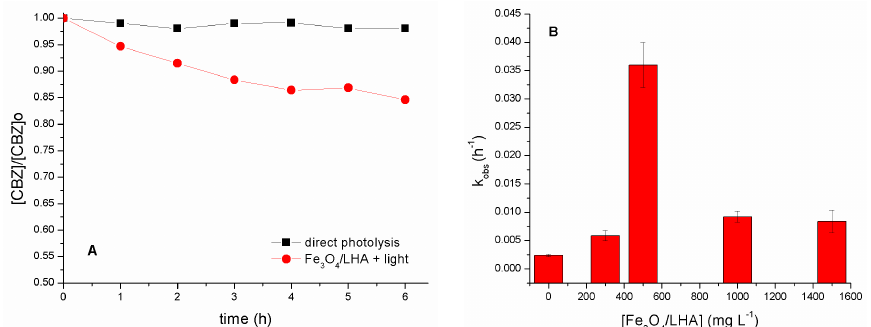
Figure 1. ( A ) Photodegradation of carbamazepine (CBZ) in the presence and in the absence of Fe 3 O 4 /Leonardite humic acid (LHA). (CBZ) 0 = 2 mg L − 1 ; (Fe 3 O 4 /LHA) 0 = 500 mg L − 1 ; pH 6.0. ( B )